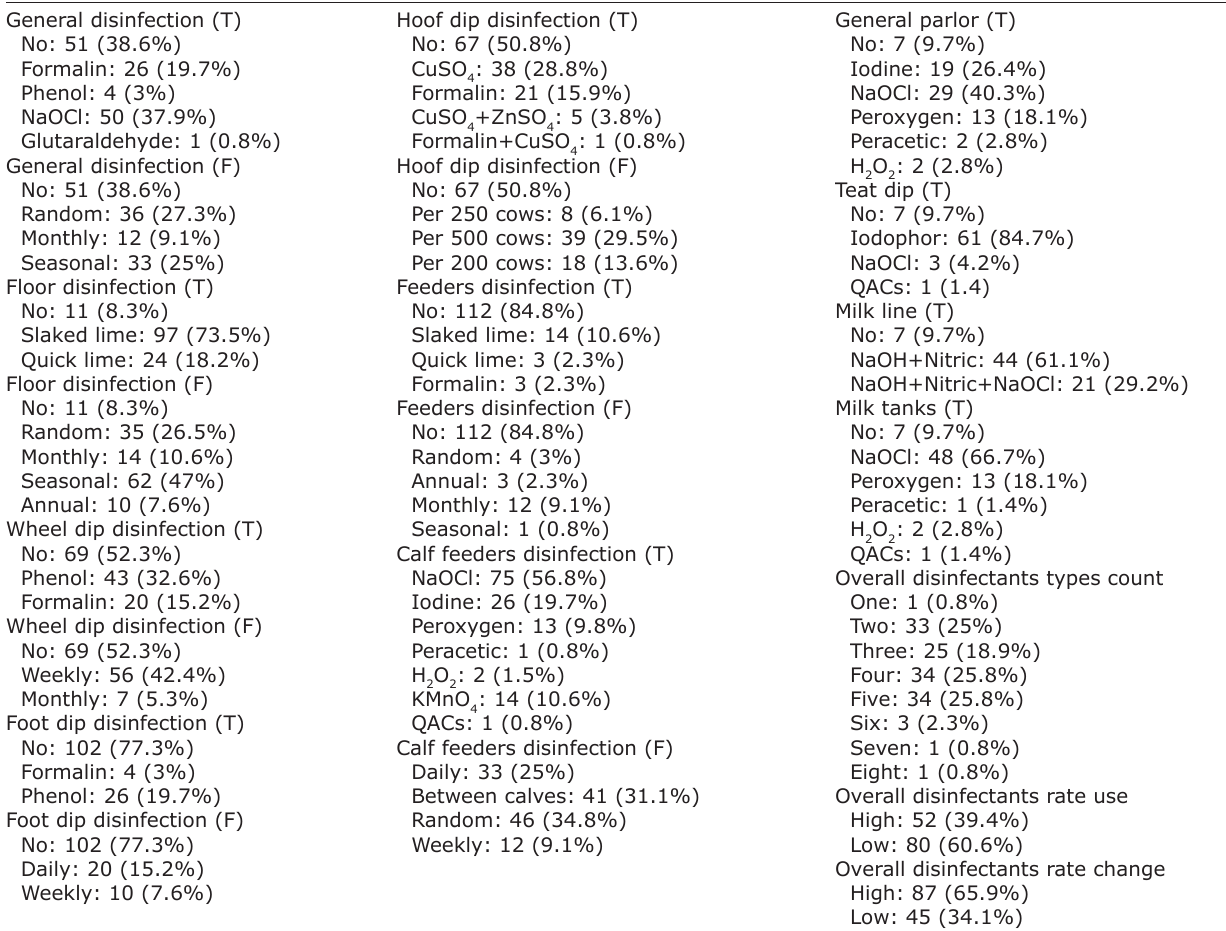
Table-1: Number (%) of the survey farms using each disinfectant type (T) and disinfectant frequency of use or change (F). General disinfection (T) No: 51 (38.6%) Formalin: 26 (19.7%) Phenol: 4 (3%)